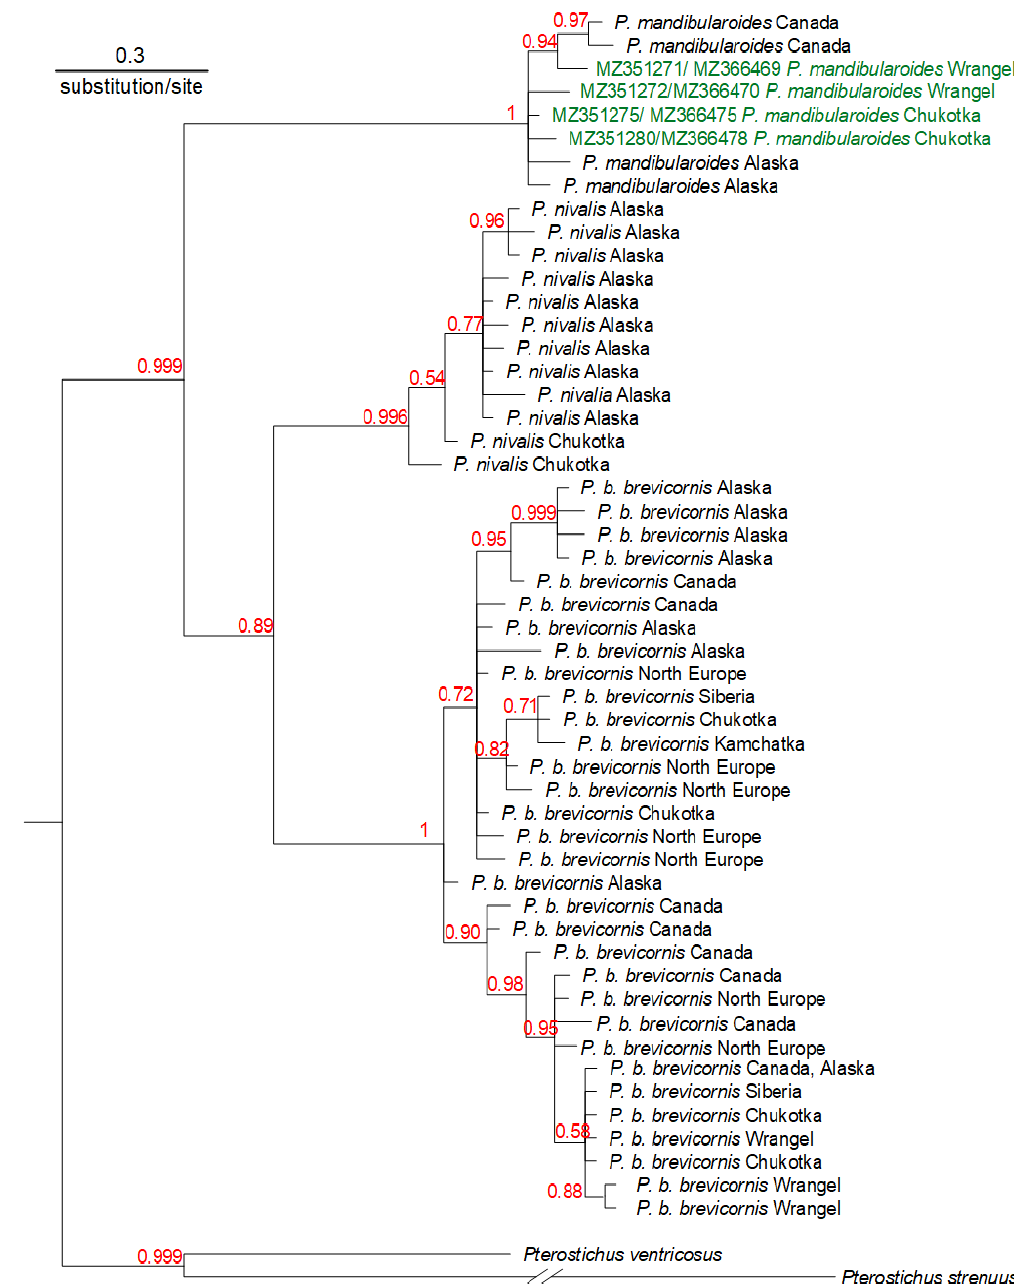
Figure 4. The majority-rule consensus phylogenetic tree of P. mandibularoides, P. b. brevicornis , and P. nivalis recovered from Bayesian inference analysis, based on the combined mitochondrial and nuclear sequence dataset (COI, 28S rRNA). Sequences of P. mandibularoides from Chukotka and Wrangel Island are highlighted in green with accession numbers to NCBI. New haplotype codes are as indicated in Table S1. Numbers near branches indicate the Bayesian posterior probability (BPP). The scale bar indicates the branch length.